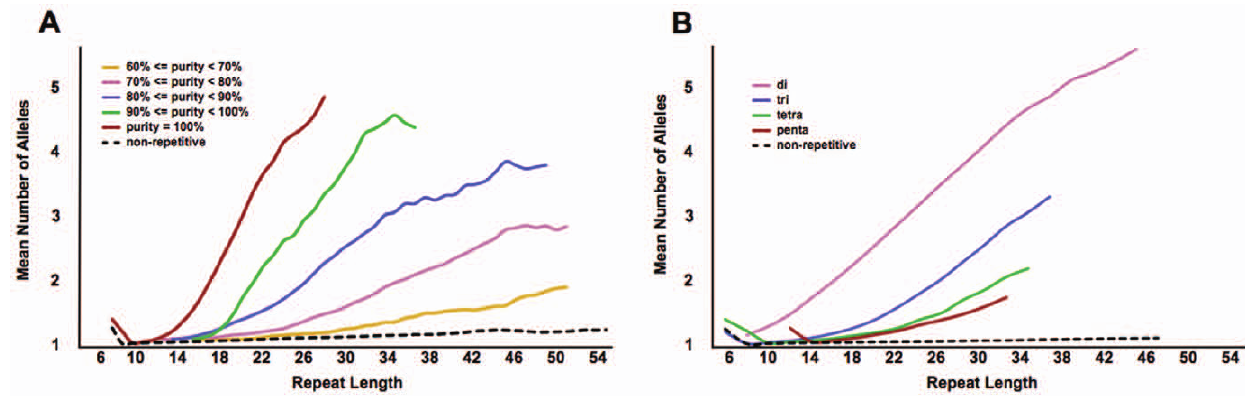
Figure 5. Variability is correlated with increasing repeat length, increasing purity, and decreasing unit size. Correlations were made using genotypes of repeats (2mers to 5mers) that were derived from genomes sequenced with a read length of at least 75 bases. Data points were plotted at each reference length bin interval that contained at least 25 repeats. The mean number of alleles (A) positively correlated with purity and (B) negatively correlated with unit size.